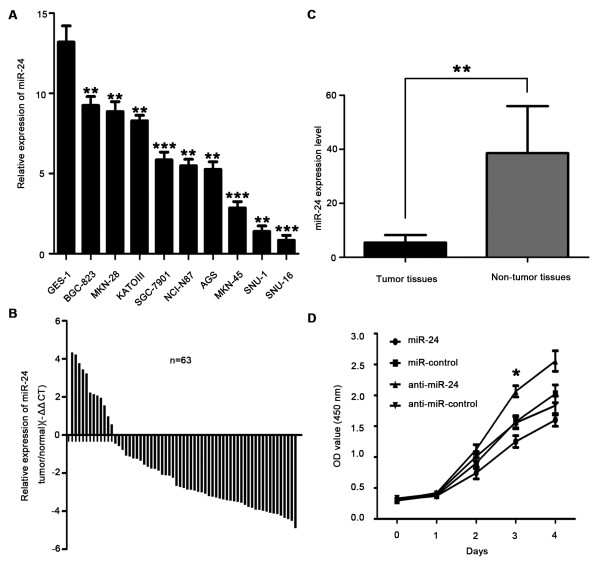
miR-24 is significantly downregulated in GC and inhibited SGC-7901 cell growth. (A) Relative expression of miR-24 in nine GC cell lines compared with GES-1 determined by qRT-PCR of three independent experiments (**P < 0.01, ***P < 0.001). (B) Relative expression of miR-24 in surgical specimens of 63 GC determined by qRT-PCR. All experiments were performed in triplicate. Data are shown as -ΔΔCT values, S.D. not shown. (C) The mean and standard deviation of miR-24 expression levels in surgical specimens of 63 GC tissues and matched non-tumor tissues are shown. Data are presented as 2-ΔCT values (**P < 0.05). U6 snRNA was used for normalization. (D) miR-24 inhibited the growth of SGC-7901 cells as detected by WST, while anti-miR-24 increased cell growth (*P < 0.05). Data are shown as mean ± S.D. of three independent experiments.